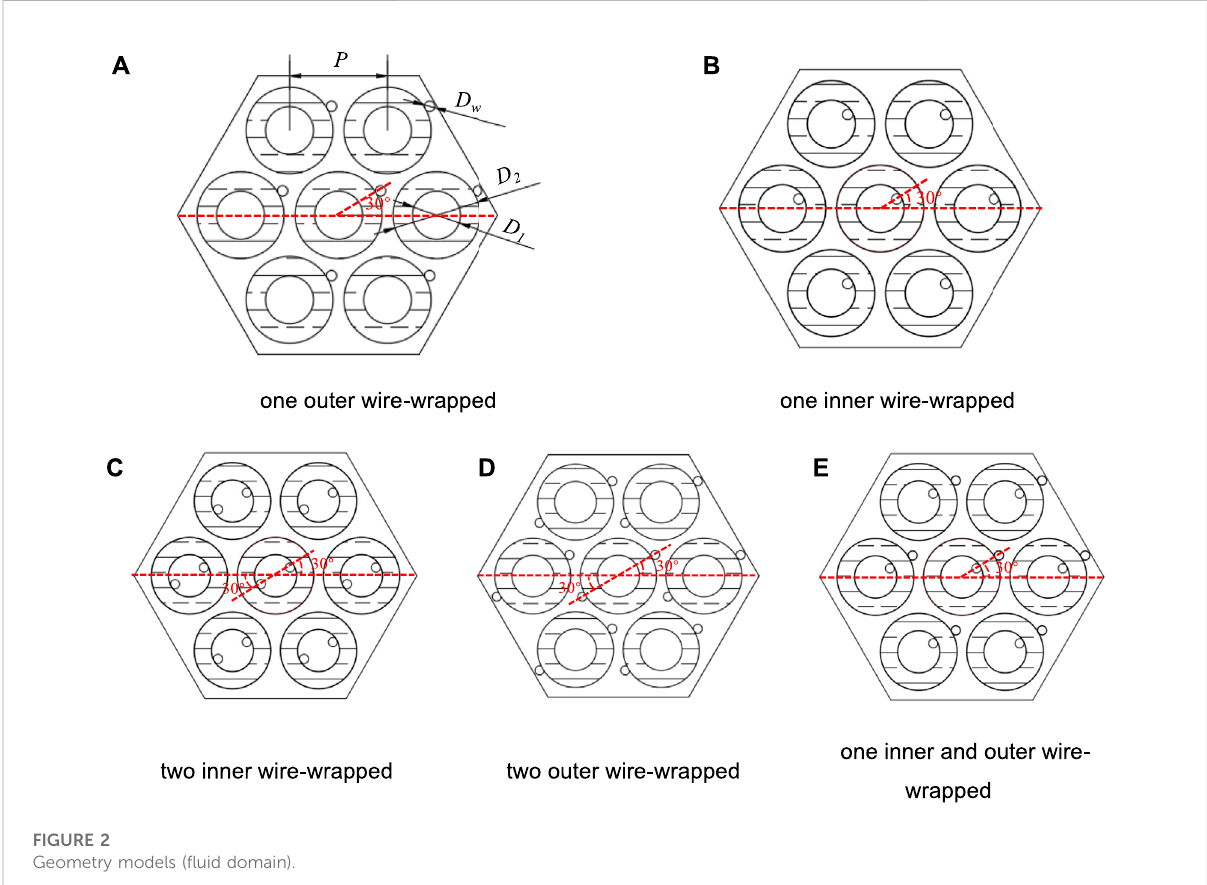
FIGURE 2 Geometry models ( fl uid